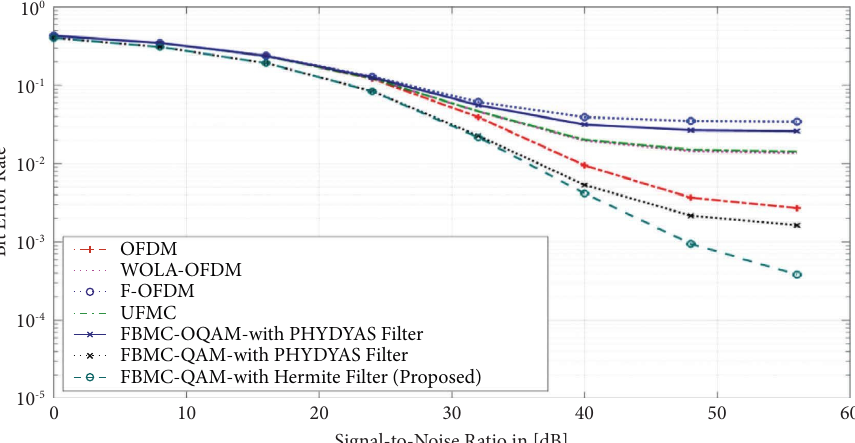
Figure 17: Bit error rate performance of diferent multicarrier modulation techniques for Pedestrian B channel model at 1024